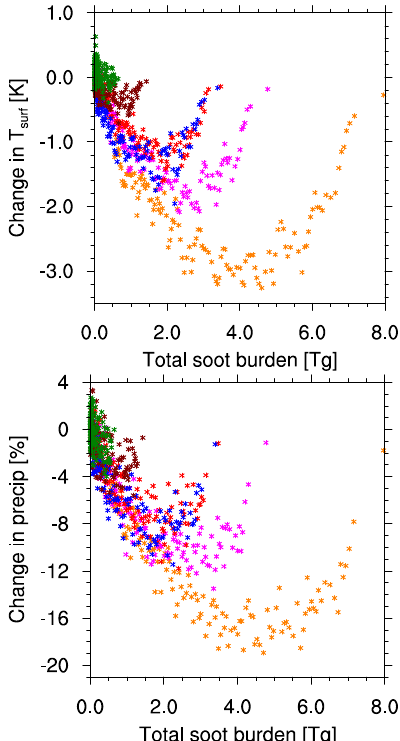
Fig. 10. Evolution of global mean temperature [ K ] (left) and precip- itation changes [ mmday − 1 ] (right) as function of total soot burden [ Tg ] , for Exp1 (green), Exp2 (brown), Exp5_100 (red), Exp5_200 (blue), Exp7 (magenta) and Exp12